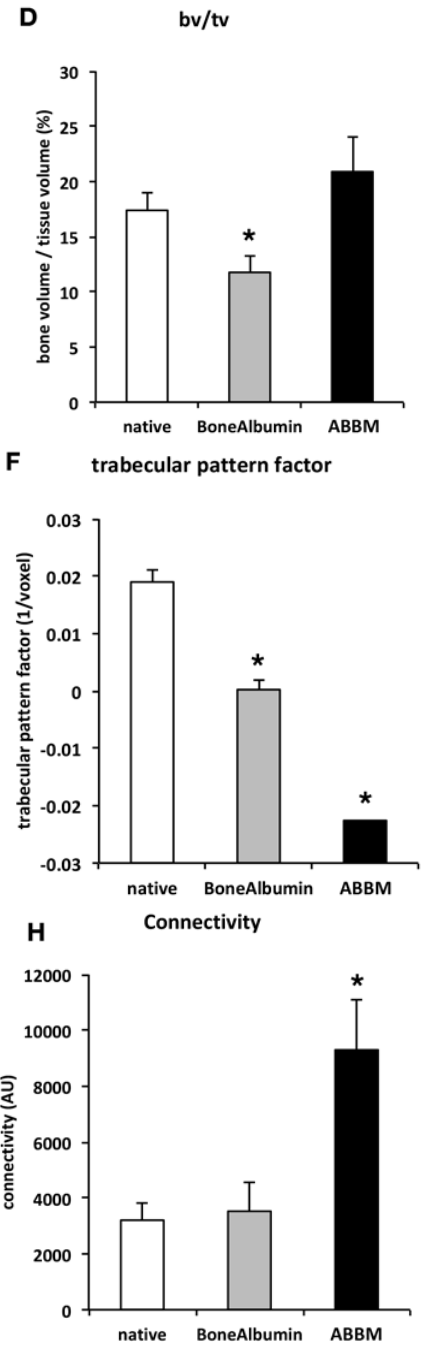
Figure 3. Panels ( A – C ) show representative µ CT images of the bone core biopsy samples at the level of the residual native bone of the alveolar ridge ( A ), the level of the augmented bone grafted using BoneAlbumin ( B ) and ABBM ( C ). Bone volume fraction (BV/TV) is still somewhat lower the BoneAlbumin group, while in the ABBM group it is comparable to that of native bone—note that what is calculated as ‘bone’ in this metric contains the unresorbed graft ceramic ( D ). Trabecular thickness of the BoneAlbumin group has not yet reached the level of that of the native bone ( E ). Trabecular pattern factor ( F ) which describe bone geometry is closer to native bone in the BoneAlbumin group than in the ABBM group. Open porosity is still somewhat higher than native in the BoneAlbumin group ( G ), while connectivity has reached the native level ( H ). Please note that in these parameters the bone value is a surrogate number for the newly formed bone and the residual graft. * signals p < 0.05 versus native bone.